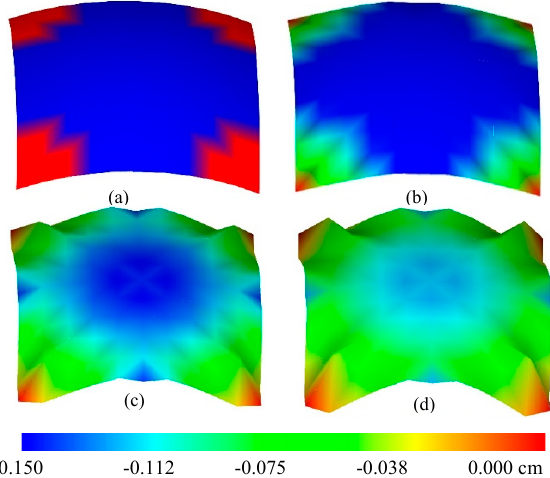
Figure 2. Z-displacement distribution of structures in Scheme A. The strain energy change ratio: ( a )